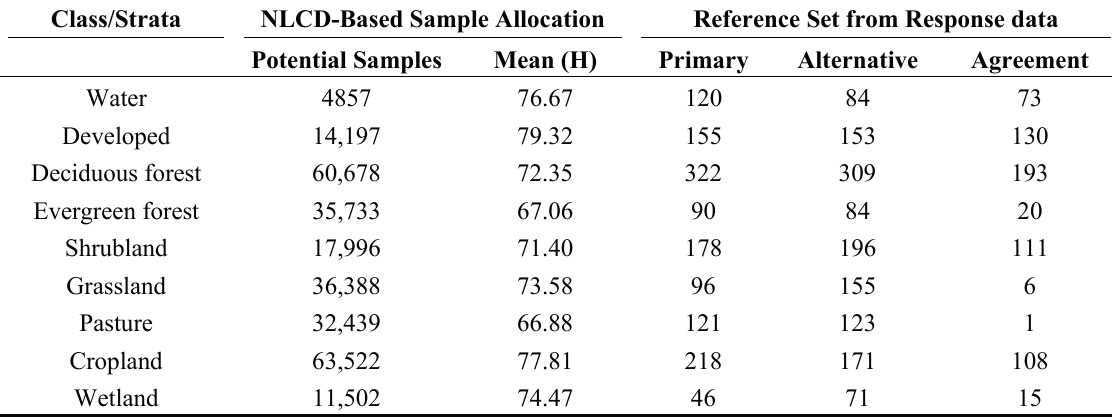
Table 8. Sample allocation from NLCD2006 (H > 50%) and location in Landsat path-rows (Figure 1) and primary and alternative reference label assignment from Landsat and Google Earth image interpretation. Agreement shows the number of samples with equal primary and alternative label. Homogeneity (H) in